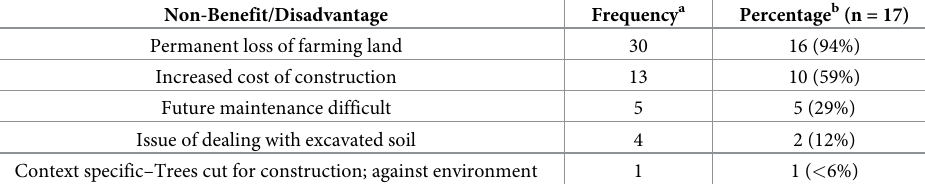
Table 2. Disadvantages associated with two-stage